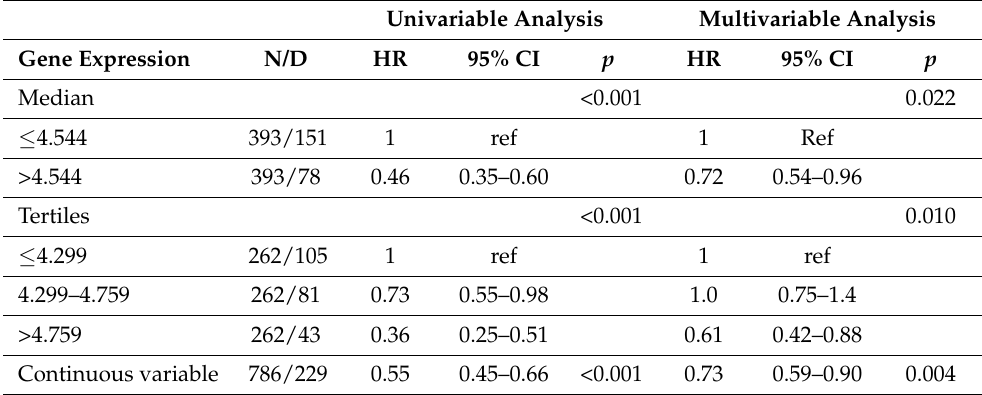
Table 2. Overall Survival of 786 NB patients in relation to RNF144A expression levels evaluated by the Cox